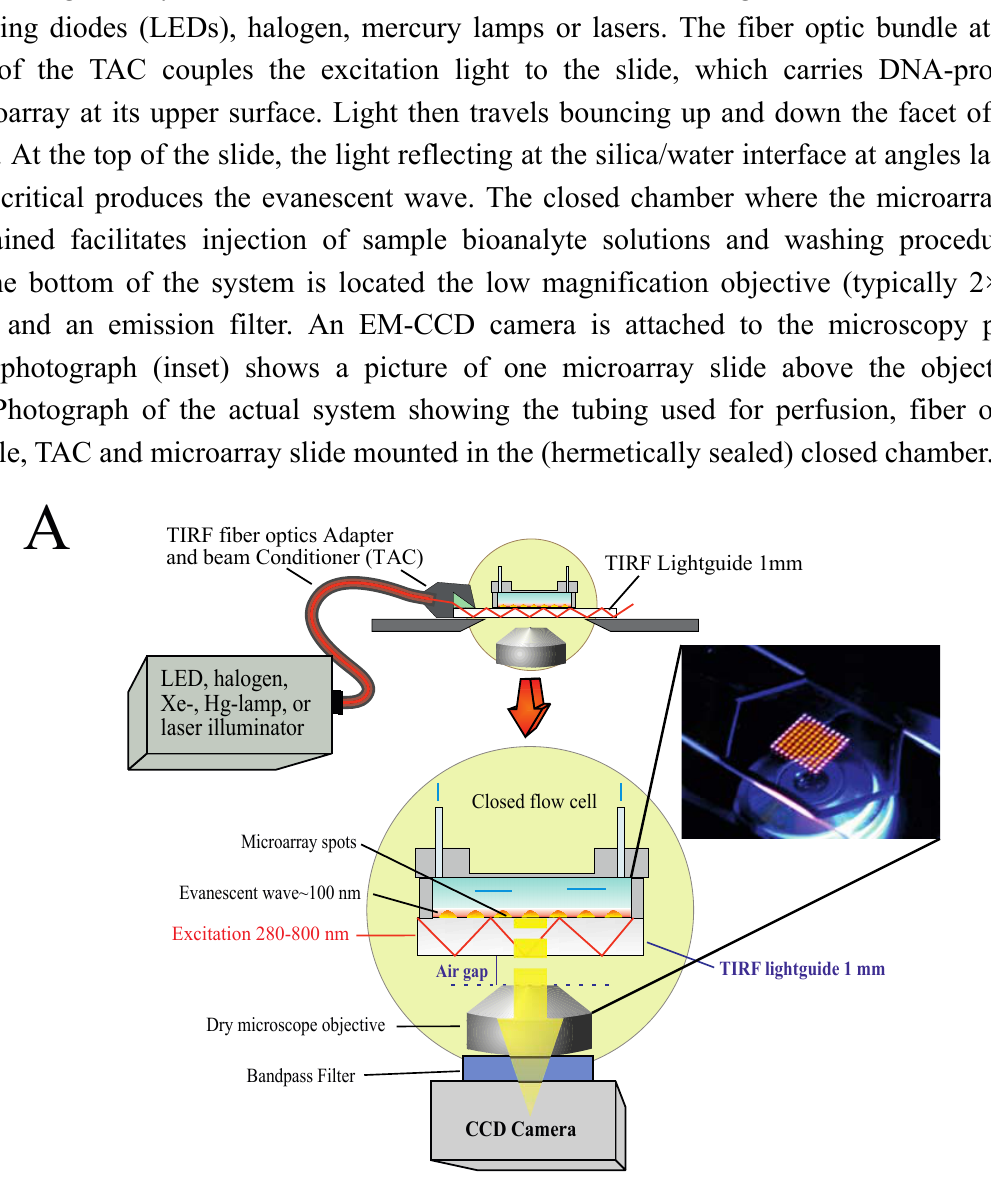
Figure 1. Implementation of the LG-TIRF-MB system. ( A ) Illustration of the